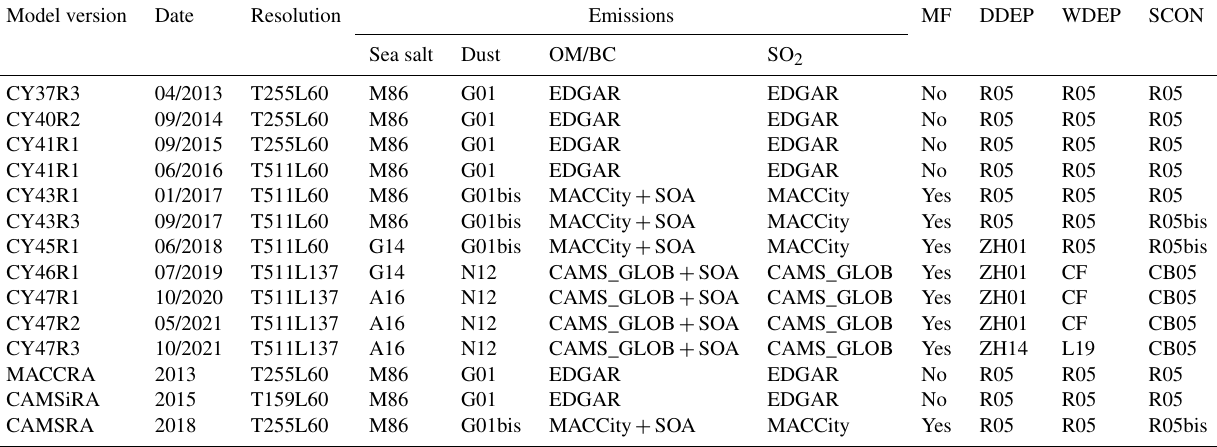
Table 4. IFS-AER cycles and options used operationally for near-real-time global CAMS products. MF stands for mass fixer, DDEP stands for dry deposition and SCON stands for sulfate conversion. G01 indicates the Ginoux et al. (2001) dust emission scheme, G01bis indicates the Ginoux et al. (2001) dust emission scheme with modified distribution of the emissions into the dust bins and N12 indicates the Nabat et al. (2012) dust emission scheme. M86, G14 and A16 indicate the Monahan et al. (1986), Grythe et al. (2014) and Albert et al. (2016) sea salt aerosol emission schemes, respectively. R05 corresponds to the version of the parameterisation described in Reddy et al. (2005). R05bis is the updated simple sulfate conversion scheme with temperature and relative humidity dependency. CF stands for the wet deposition parameterisation using condensation fluxes (as implemented in cycle 46R1). L19 stands for wet deposition based on Luo et al. (2019). ZH01 and ZH14 stand for the Zhang et al. (2001) and Zhang and He (2014) dry deposition parameterisations, respectively. MACCRA, CAMSiRA and CAMSRA are the MACC Reanalysis (Inness et al., 2013), the CAMS interim Reanalysis (Flemming et al., 2015) and the CAMS Reanalysis (Inness et al., 2019), respectively. For the three reanalyses, the date column refers to when the data were first publicly